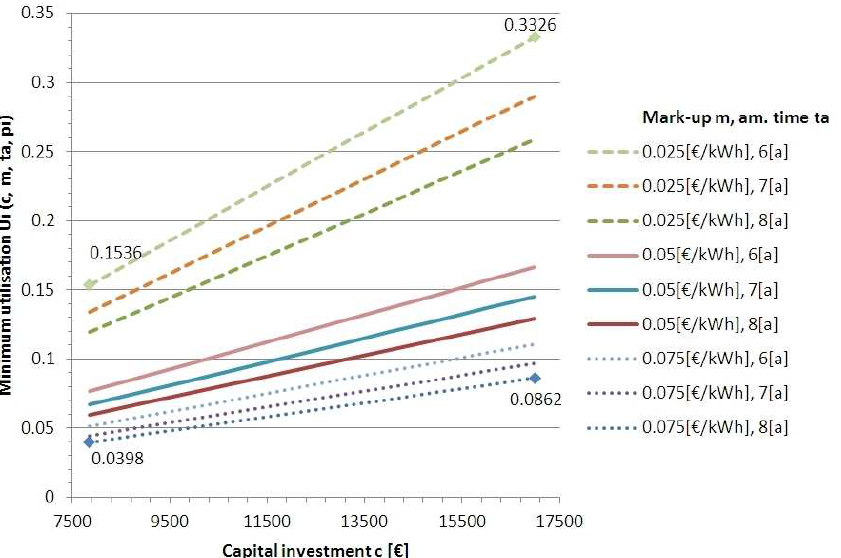
Figure 5. Minimum utilisation U i of a charging station for charging power p i =44kW and different combinations of parameters c, m and t a